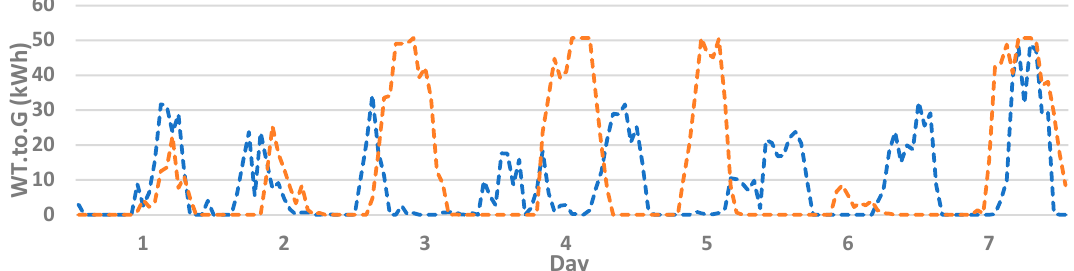
Figure 11. Energy transmission from wind turbines to the grid. Comparison between the most and least probable scenarios (blue and orange) for one week of April. Source: self-elaboration. Energies 2020 , 13 , x FOR PEER REVIEW